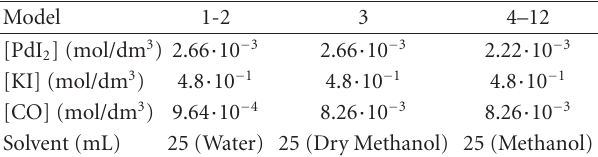
Table 2: Initial conditions used in modelling studies.